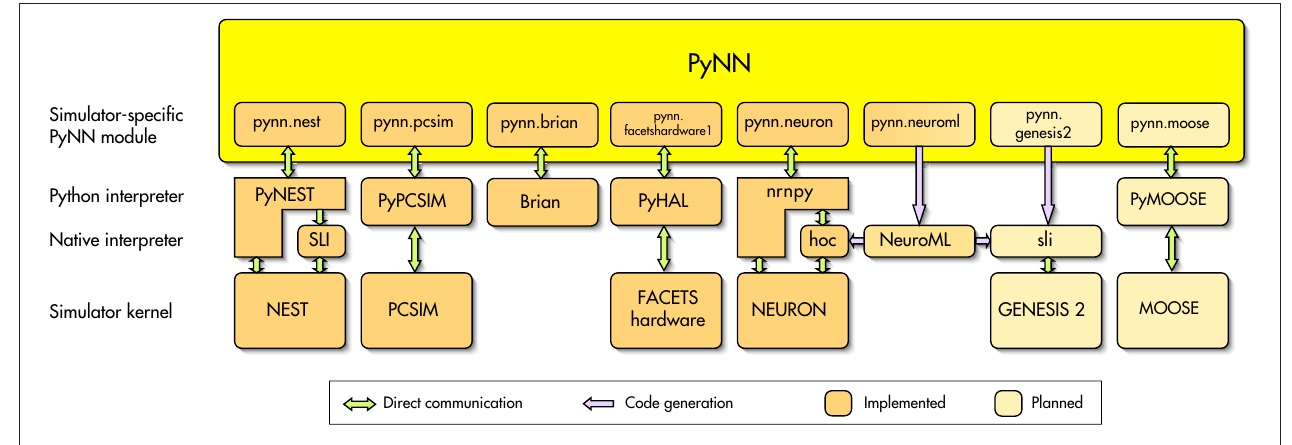
FIGURE 3 | The architecture of